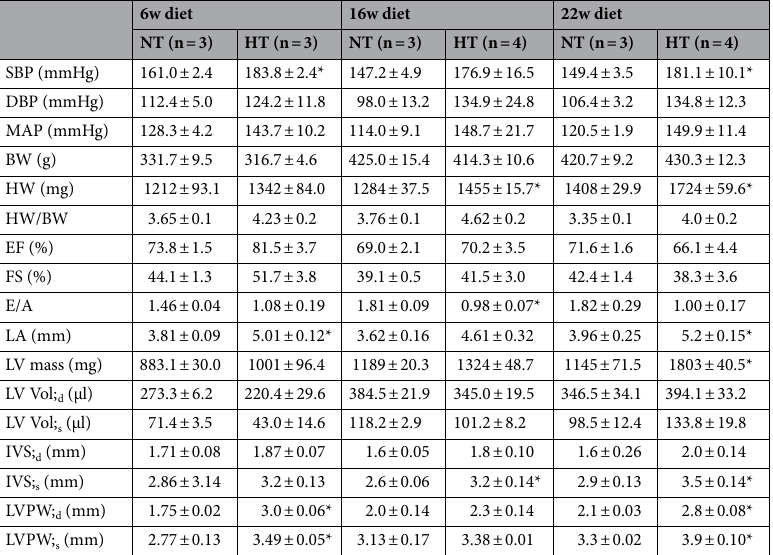
Table 1. Time-course hemodynamic, autoptic and echocardiographic main characteristics of normal and high-salt fed Dahl/SS